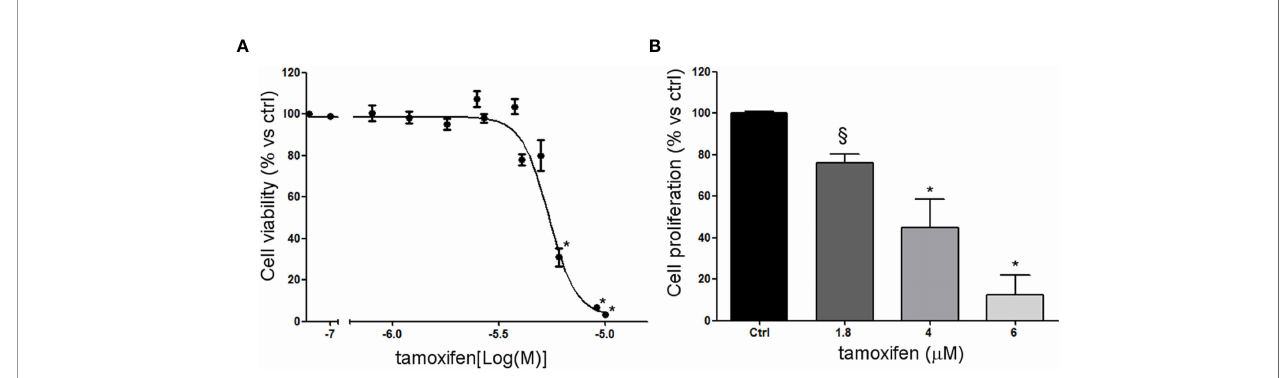
FIGURE 2 | Effect of tamoxifen on NCI-H295R cell viability and proliferation. (A) NCI-H295R were treated with increasing concentration of tamoxifen (0.1 – 20 uM) and cell viability was then evaluated by MTT assay. Results are expressed as percent of viable cells vs ctrl ± SEM of three independent experiments run in triplicate.